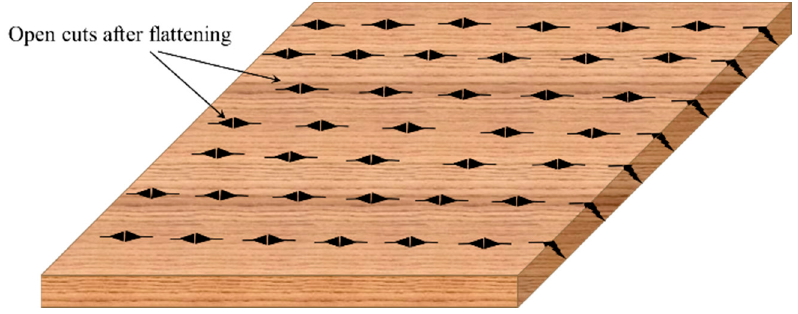
Figure 8. Scratches on the internal layer of flattened bamboo.